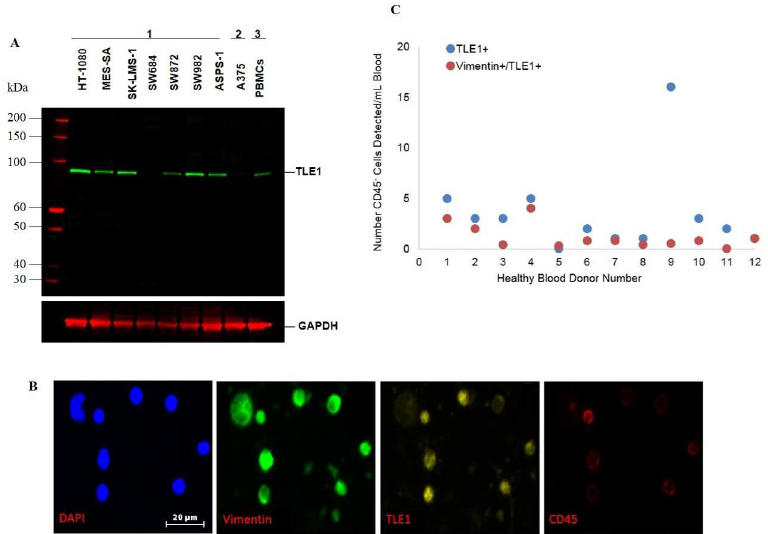
Fig 4. Validation of TLE1 as a tumor-specific markerof sarcoma. TLE1 (Transducin-LikeEnhancer Protein 1) was identified as tumor-specific marker for sarcomas. (A) Westernblot analysisof TLE1 (MW ~83 kDa) in: 1: sarcomacell lines;2: melanomacell line; 3: PBMCs. GAPDH (MW ~37 kDa)servedas a loadingcontrol. (B) CTCs isolatedfrom the bloodof a patientwithsarcomaandcharacterized by TLE1 (yellow),vimentin (green), andDAPI (blue), whileexcluding CD45 + leukocytes (red) staining(4 channels);representative 80X imagesare shown.Scale bars indicate20 μ m. (C) Determination of false positiveCD45-/Vimentin+/TLE1+ cellsin a panelof healthyblooddonors.